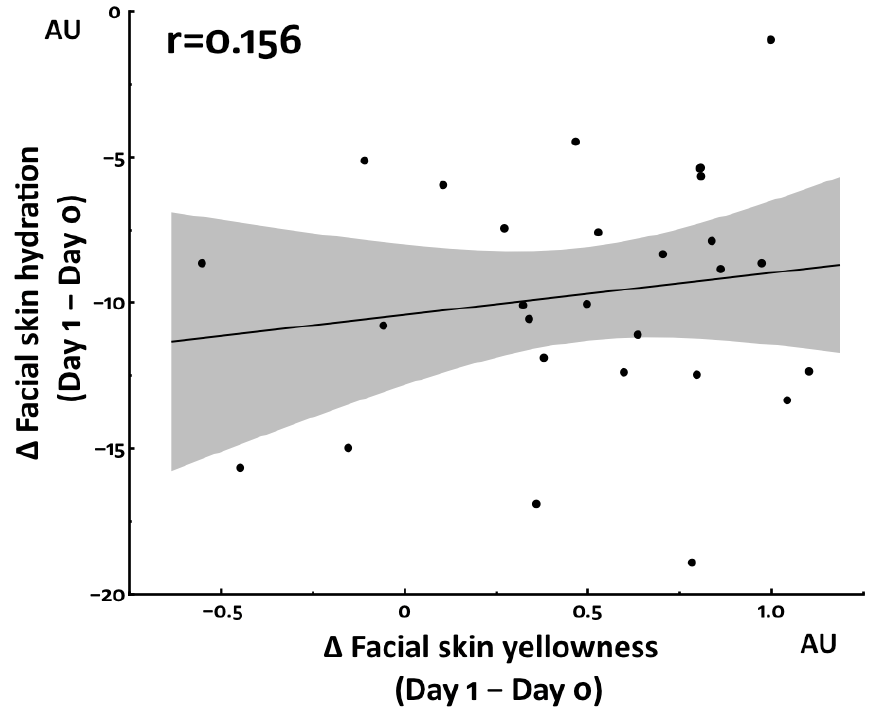
Figure 3. Association between facial skin yellowness and hydration in total sleep deprivation study.